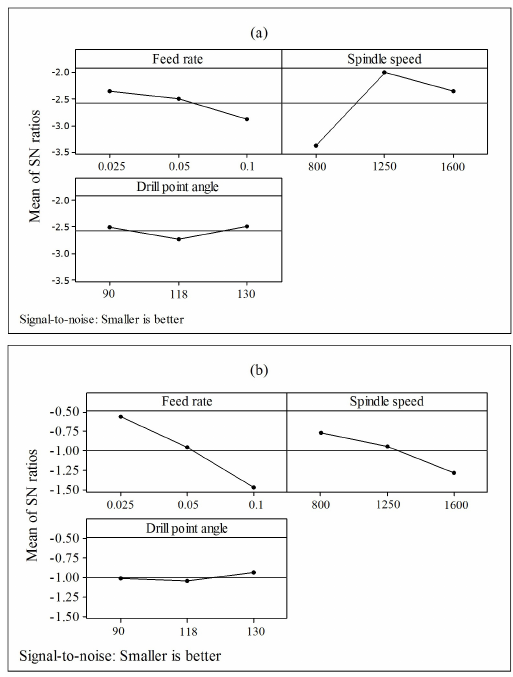
Figure 6. Effect of process parameters for (a) un- supported drilling, (b) supported